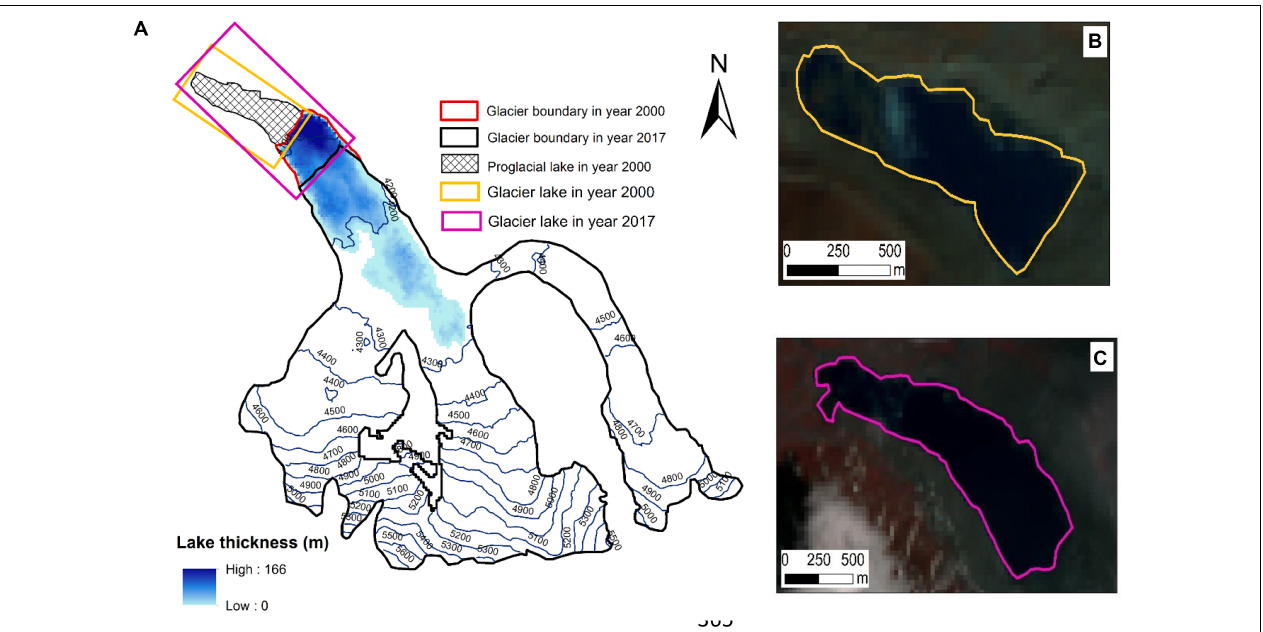
FIGURE 5 | (A) Gepang Gath Glacier boundary in the year 2000 and 2017. Blue region shows the extent of potential future glacial lake observed from the year 2000 data. (B) Proglacial lake in the year 2000 (Image Source: Landsat 7—15 Oct 2000) and (C) proglacial lake in the year 2017 (Image Source: Landsat 8—16 June 2017).